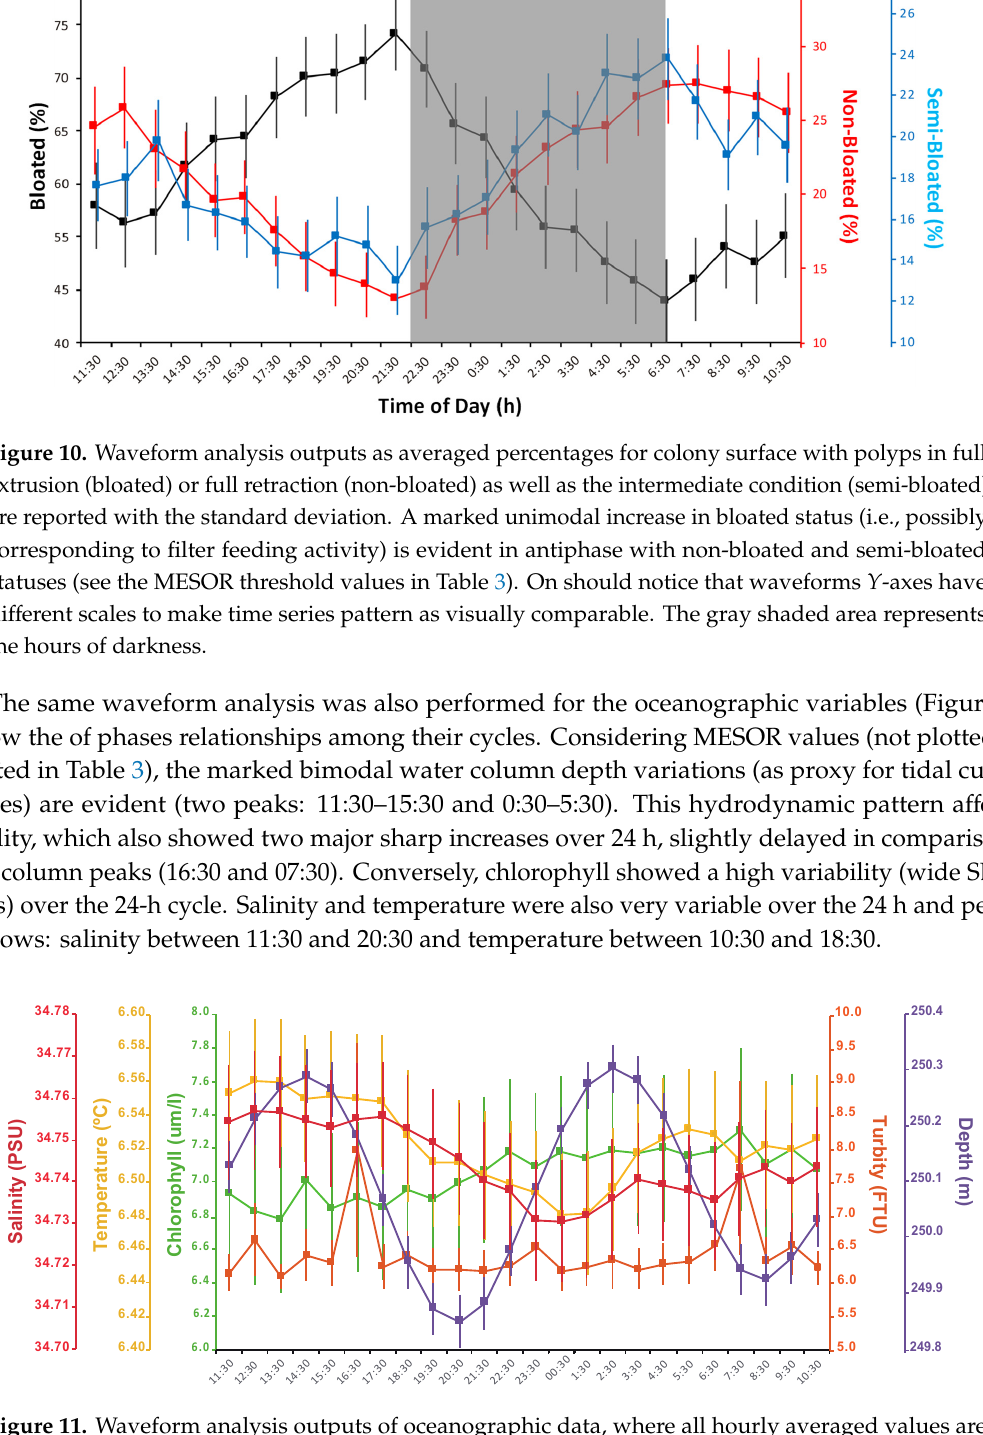
Figure 12. Seasonal pattern of variation in P. arborea polyps’ activity and concomitantly measured oceanographic variables. ( A ) Monthly average percentages of different polyp activity statuses. ( B ) Monthly averaged oceanographic variables. All data are presented with the standard deviation.